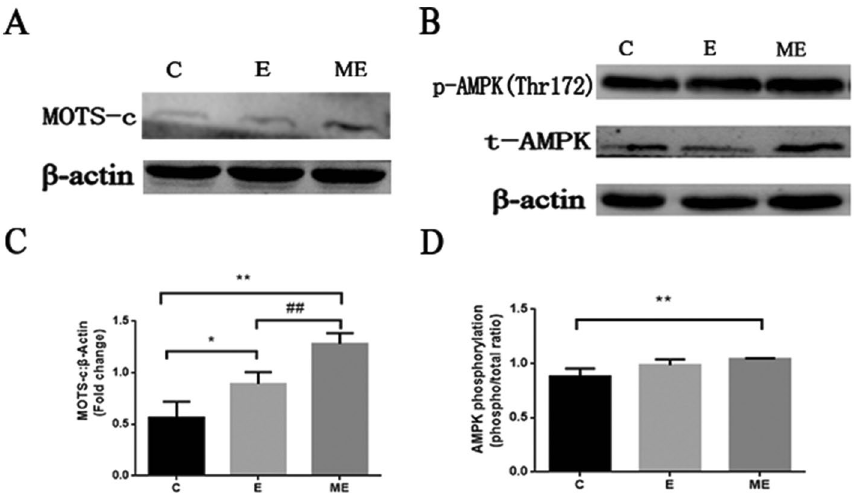
Figure 6. Changes in the protein expression of MOTS-c, p-AMPK, and t-AMPK in each group of rats. ( A and B ) are the representative images of MOTS-c, p-AMPK(Thr172), t-AMPK. ( C ) is the change of MOTS-c compared to β-Actin multiple. ( D ) is stoichiometric AMPK phosphorylation (phosphor/total ratio). * p < 0.05, ** p < 0.01, compared to group C. # p < 0.05, ## p < 0.01, compared to group E. (C = Control, E = Exercise training, ME = Exercise training combined with MOTS-c